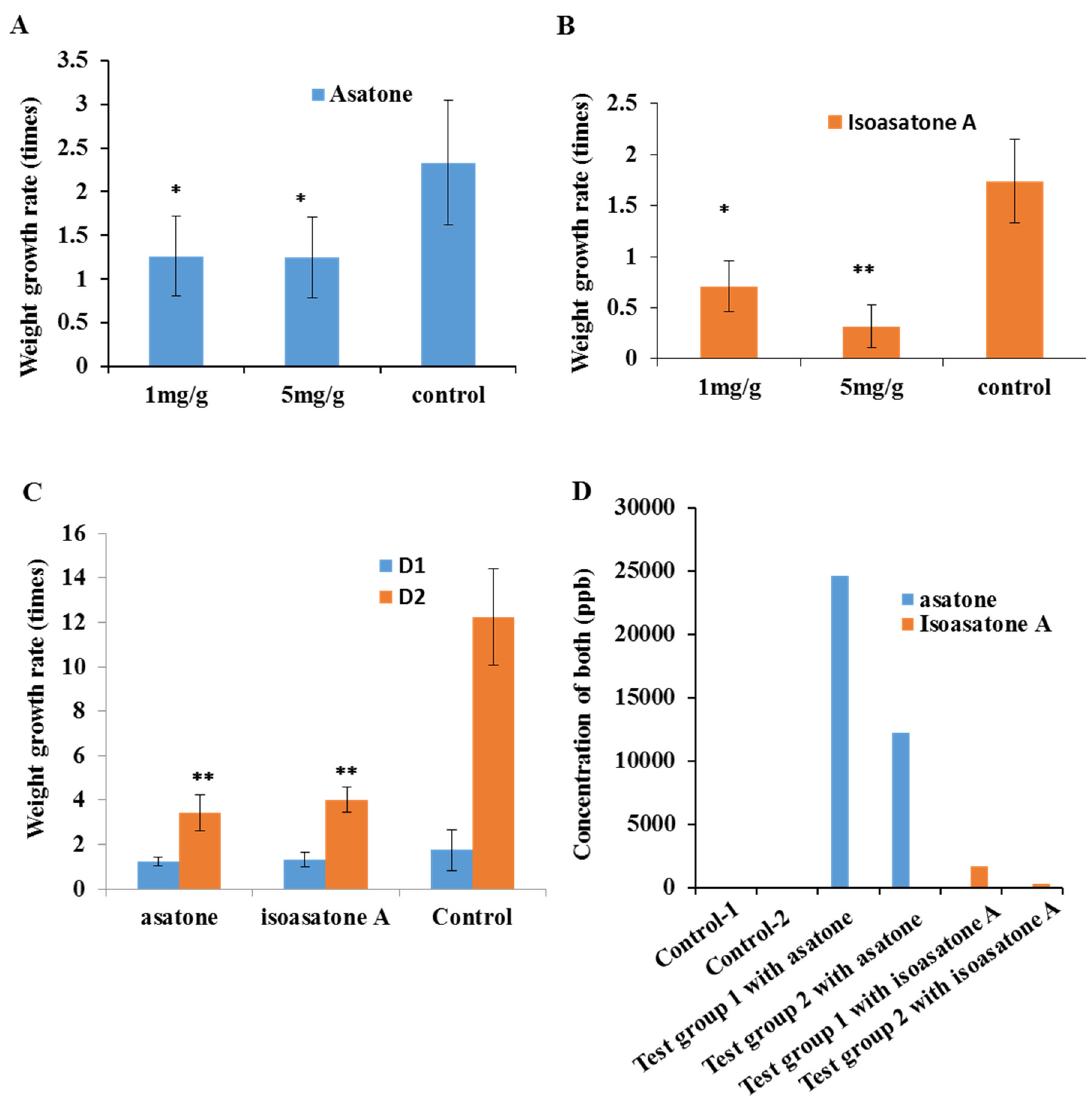
Figure 2. Anti-insect activity of asatone and isoasatone A. ( A ) Different concentrations of asatone against Spodoptera litura after 2 d. ( B ) Different concentrations of isoasatone A against Spodoptera litura after 2 d. ( C ) Growth rate of Spodoptera litura growth rate on an artificial diet (1 mg/g) with different day. ( D ) Concentration of asatone and isoasatone A in S. litura by feeding test artificial diet . Growth rate with one asterisk indicates a significant difference ( p < 0.05) and a double asterisk indicates significance at p < 0.01 relative to control in a t -test.